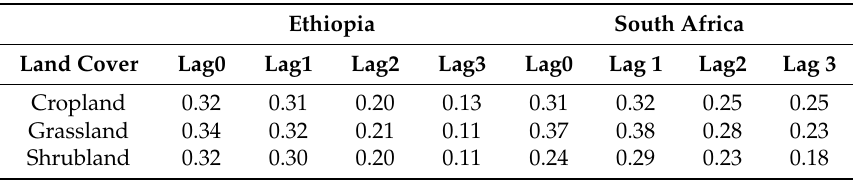
Figure 10. Correlation coefficient ( top ) and p -value ( bottom ) between RZSM and NDVI anomalies for different lag times. Table 2. The Pearson’s correlation coefficient computed between agricultural-based drought indices and meteorological-based drought indices for different land cover